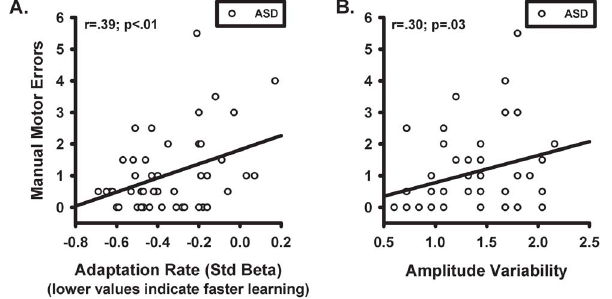
Figure 5. Relationships between saccade adaptation and manual motor performance. The number of errors during the manual motor test were averaged across hands and are presented for subjects with ASD in relation to A) the rate at which they adapted and B) their trial-to-trial amplitude variability across baseline testing and the adaptation and recovery